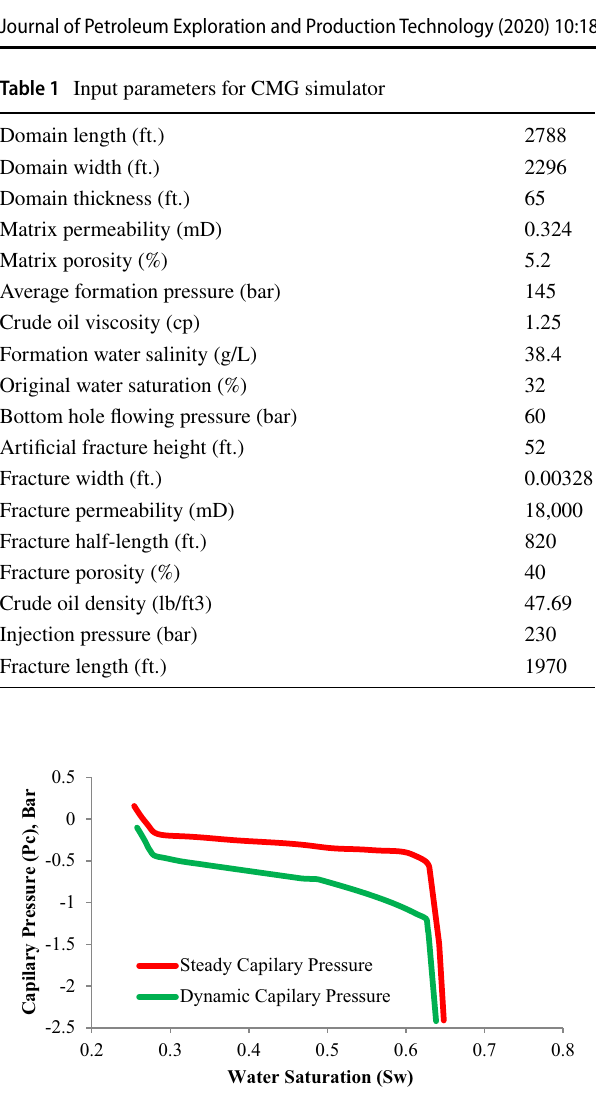
Fig. 2 Capillary pressure in the matrix for the CMG model